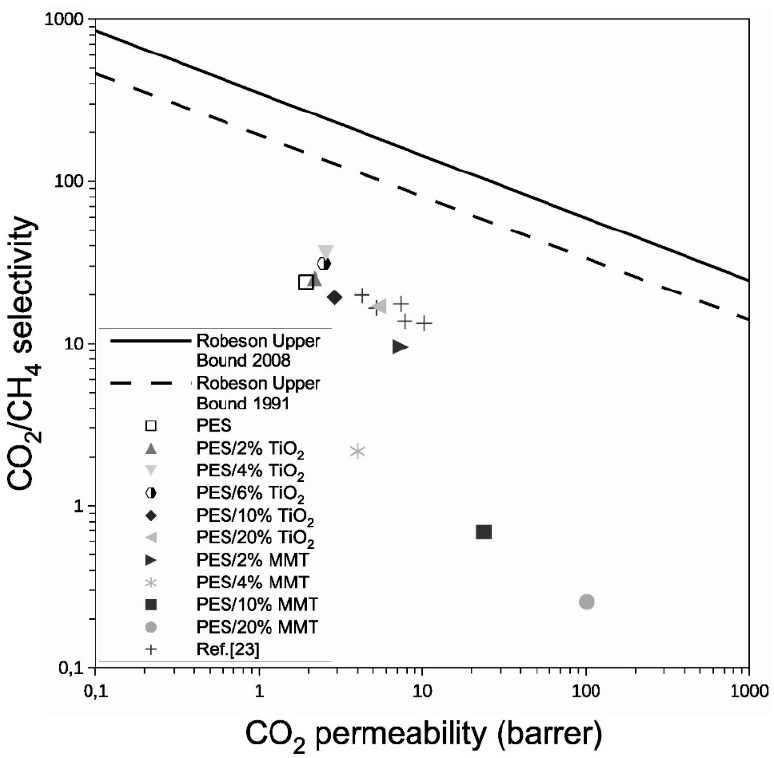
Figure 13. Performance of MMMs compared to the Robeson upper bounds [124].